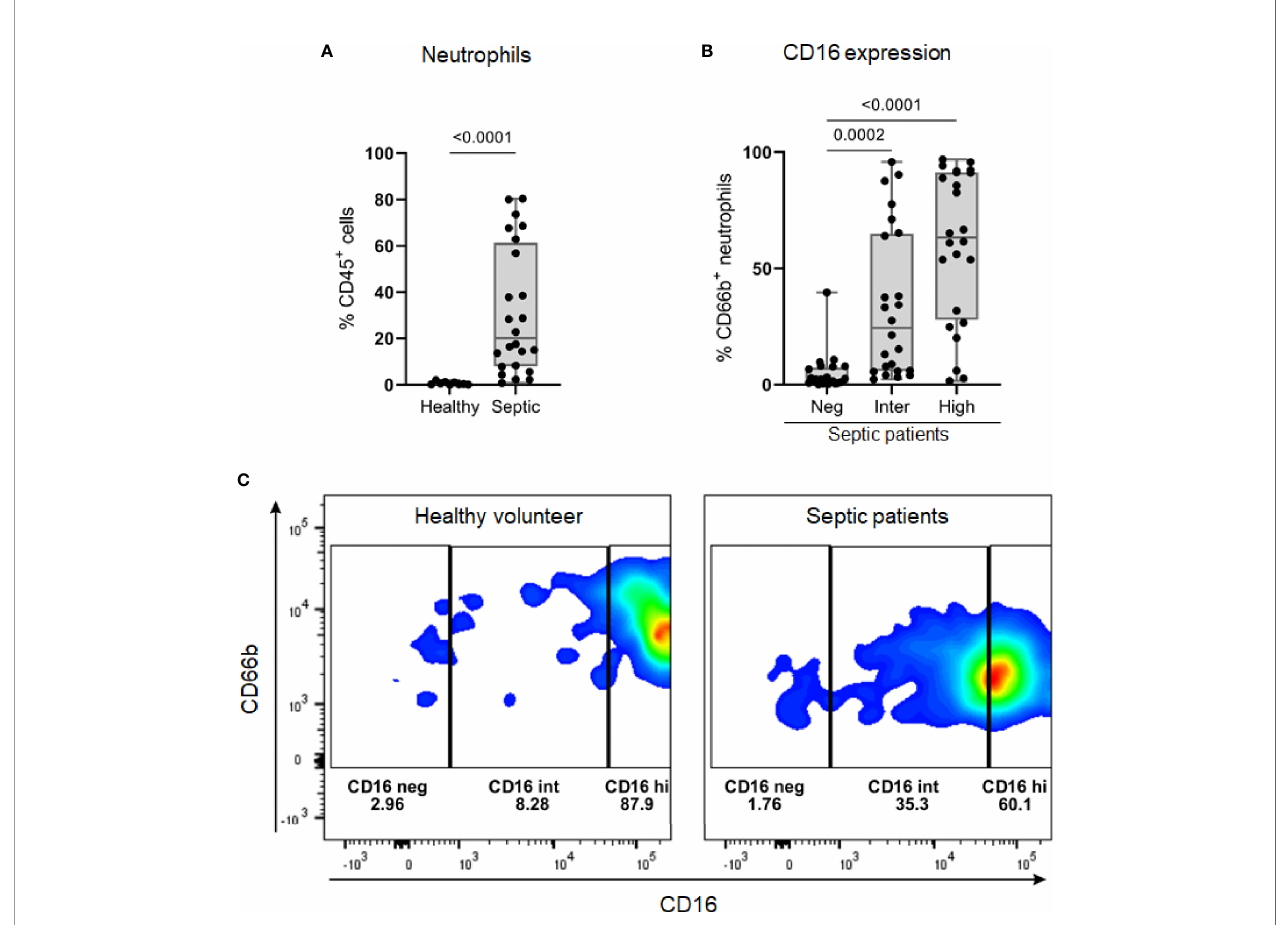
FIGURE 6 | The identi fi cation of low-density neutrophil populations in septic patients. (A) Percentage of CD66b+ neutrophils, gated on viable CD45+ cells, in PBMC samples from healthy volunteers ( n = 9) and septic patients ( n = 24). (B) Overall percentage of CD16 populations (negative, intermediate, and high) gated on CD66b+ neutrophils in PBMC from septic patients ( n = 24). (C) Representative dot plots of CD16 populations in CD66b+ neutrophils from one healthy volunteer (left) and one septic patient (right). Data are presented in box plots showing all individual values. P -values were determined using Mann – Whitney test (A) or Kruskal-Wallis test followed by Dunn ’ s test (B)